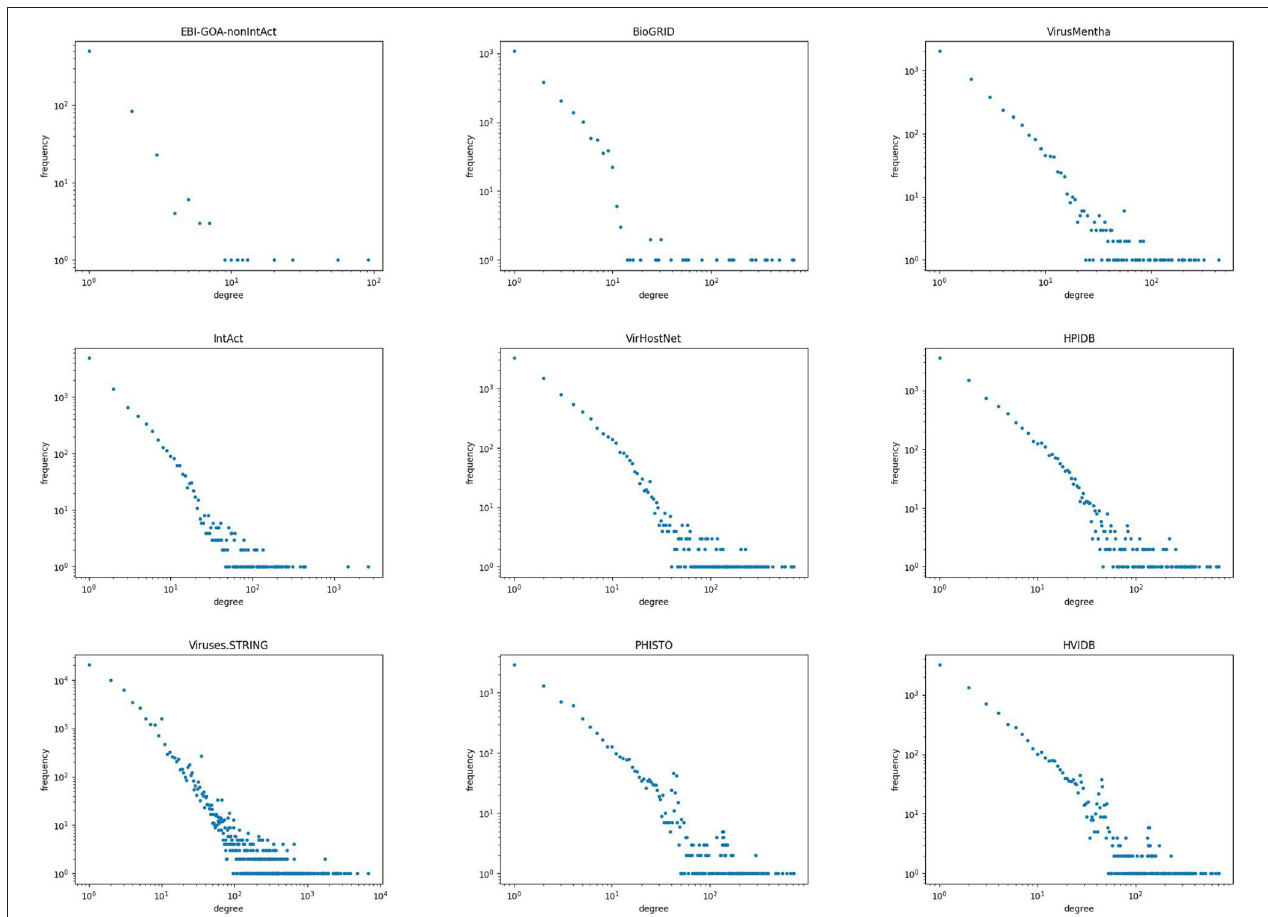
FIGURE 2 | Degree distribution of the virus-host protein–protein interaction